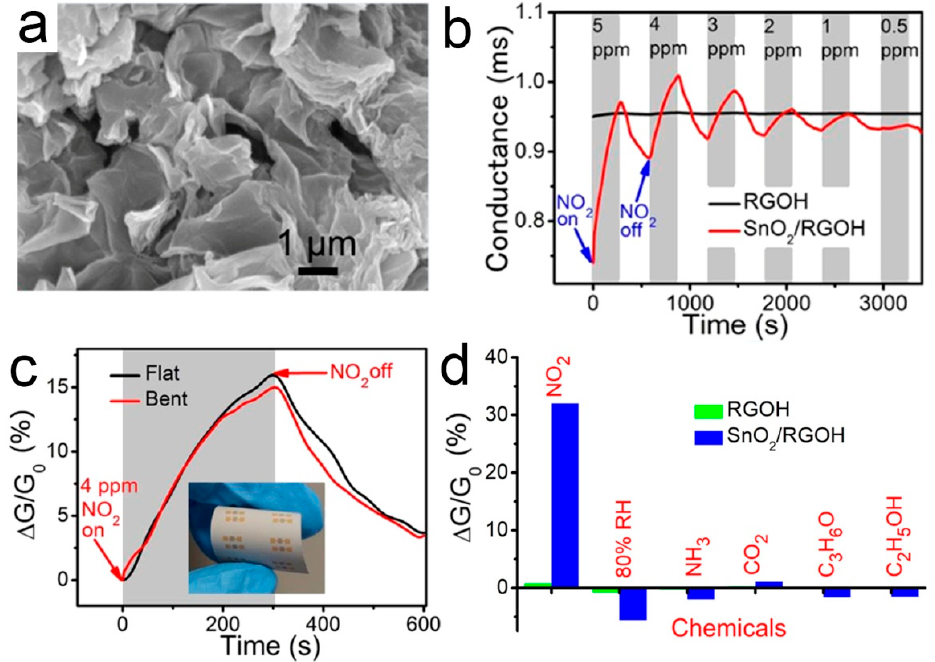
Figure 5. ( a ) SEM image of 3D SnO 2 /RGOH; ( b ) Dynamic responses of RGOH and SnO 2 /RGOH to NO 2 ; ( c ) RT responses of SnO 2 /RGOH and RGOH; ( d ) Real-time responses of the flexible SnO 2 /RGOH sensor. Inset: Photograph of the sensor with the bent angle of 150° [85]. SnO 2 /RGOH sensor. Inset: Photograph of the sensor with the bent angle of 150 ◦